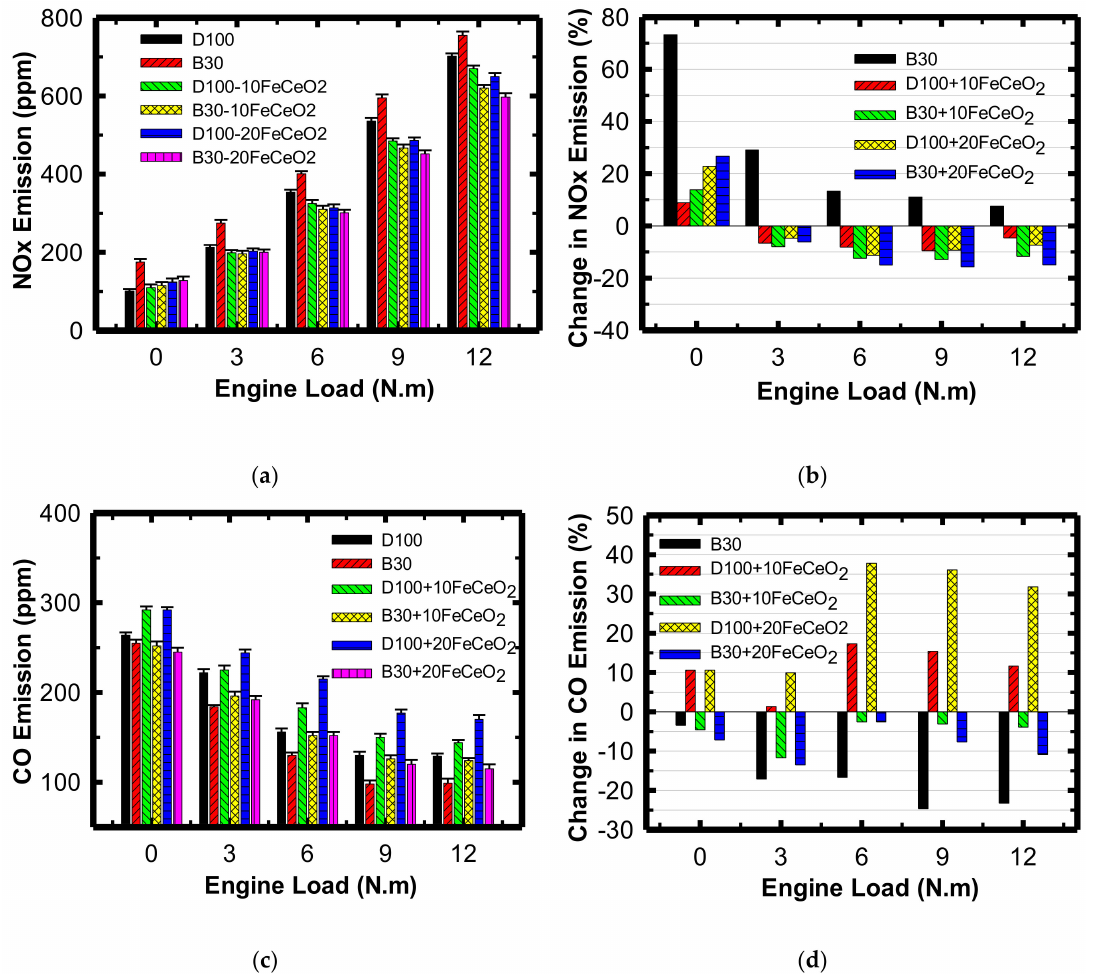
Figure 9. The engine emissions at different loads for different fuels at a speed of 2000 rpm: ( a ) NO x emission, ( b ) change in NOx emission relative to D100, ( c ) CO emission, and ( d ) change in CO emission relative to